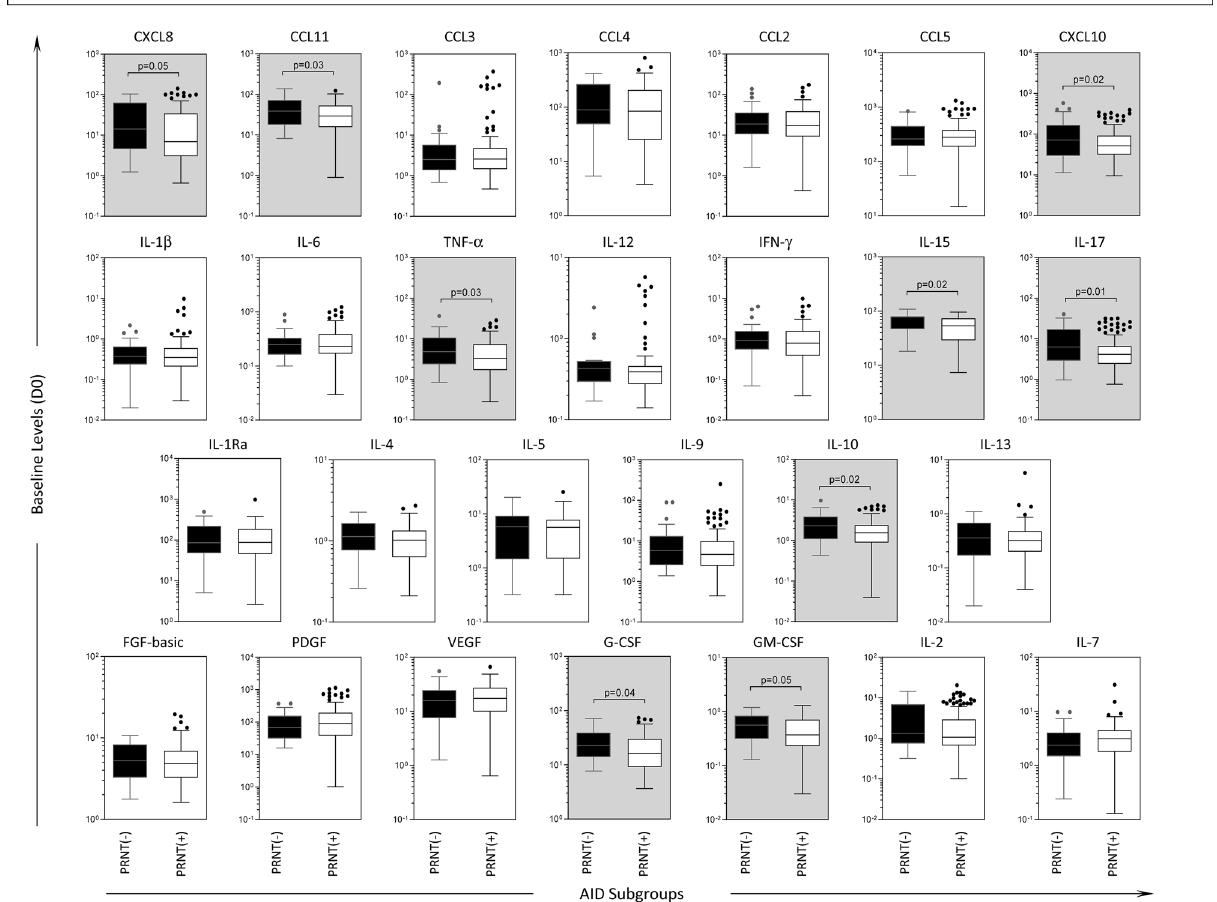
Figure 3. Baseline Profile of Serum Biomarkers in Patients with Autoimmune Disease According to the Neutralizing Antibody Status After Planned Primary 17DD-YF Vaccination. Baseline levels of serum chemokines (CXCL8, CCL11, CCL3, CCL4, CCL2, CCL5, CXCL10), pro-inflammatory cytokines (IL-1β, IL-6, TNF-α, IL-12, IFN-γ, IL-15, IL-17), regulatory cytokines (IL-1Ra, IL-4, IL-5, IL-9, IL-10, IL-13), and growth factors (FGF-basic, PDGF, VEGF, G-CSF, GM-CSF, IL-2 and IL-7) in serum samples from Autoimmune Disease patients, categorized according to the PRNT status after primary 17DD-YF vaccination: AID/PRNT(−) (black filled square, n = 32) and AID/PRNT(+) (white filled square, n = 108). Measurements were carried out using the Luminex platform, according to manufacturer’s instructions as provided in Material and Methods. The results are expressed as median levels (pg/mL) at baseline (D0) on boxplot charts. Comparative analysis between AID/ PRNT(−) and AID/PRNT(+) was carried out by Mann–Whitney test and significant differences at p < 0.05 underscored by connecting lines and highlight with gray background. The exact p values are provided in the